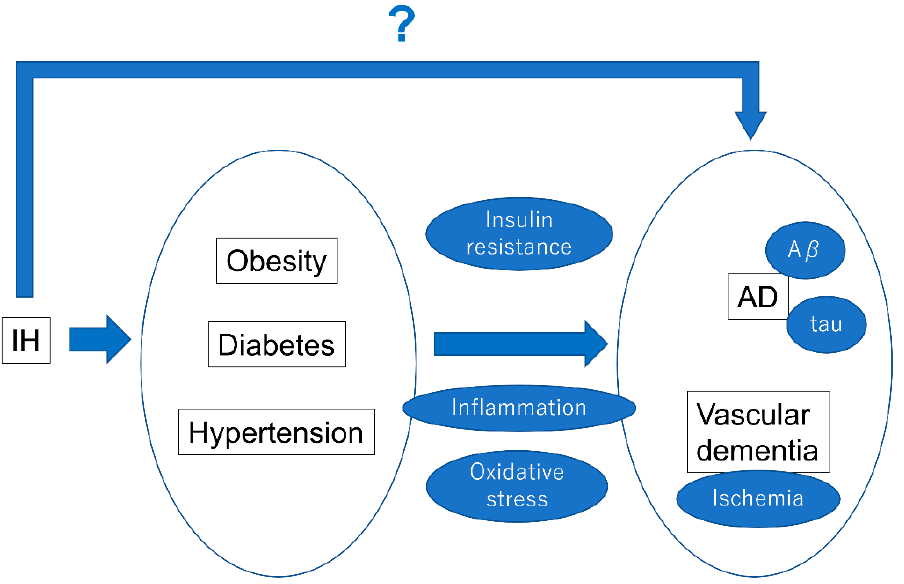
Figure 4. The relationship between IH, metabolic syndrome, and dementia. The contribution of IH to obesity, diabetes, and hypertension is becoming clearer and clearer. Moreover, evidence of the contribution of obesity, diabetes, and hypertension to dementia is growing. Future clarification of the direct effects of IH on the causative factors of dementia is awaited.